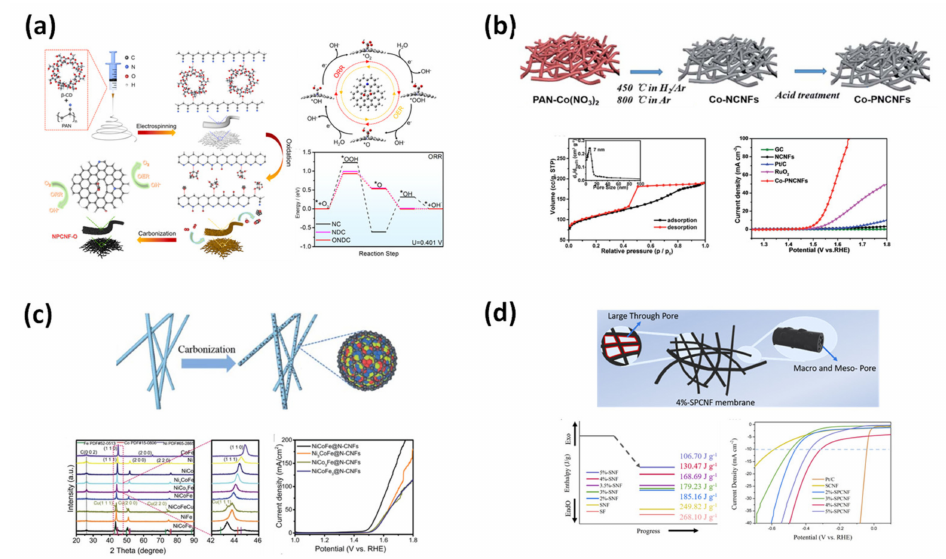
Figure 16. ( a ) Effects of β -CD surfactant on the catalytic activation of porous CNFs in ORR/OER fuel cell [118]. ( b ) CNFs decorated with Co nanoparticles for OER catalyst material [121]. ( c ) NiCoFe metal alloy for catalyst material of both ORR and OER systems [122]. ( d ) CNF fibers from fibroin of silk for catalyst material